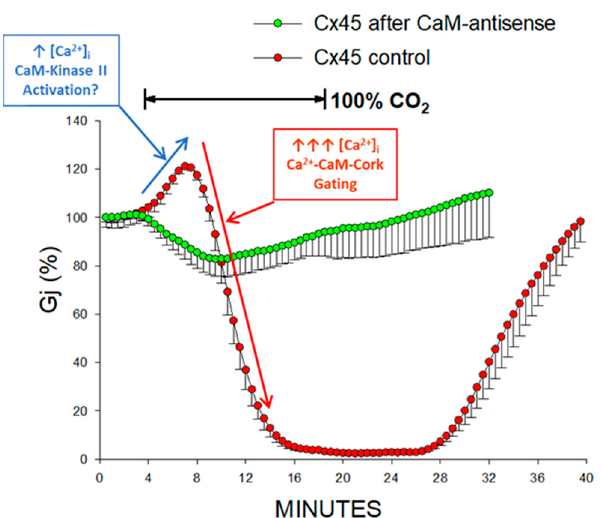
Figure 3. The junctional conductance (Gj), monitored in Xenopus oocyte pair expressing Cx45 during CO 2 application, has a biphasic course: initial rise followed by a rapid drop to full uncoupling (red circles). Since activation of CaMKII increases Gj (see text), the initial Gj rise may result from activation of the CaMKII cascade and opening of dormant, CaM-Cork gated channels. We believe that subsequent rapid Gj drop results from the activation of the Ca-CaM-Cork mechanism. Inhibition of CaM expression greatly reduces the CO 2 sensitivity, as Gj reversibly drops (monophasically) by only ~17% (green circles)—the absence of Gj rise suggests that with reducing [CaM] i at rest, most channels are open. From [38].